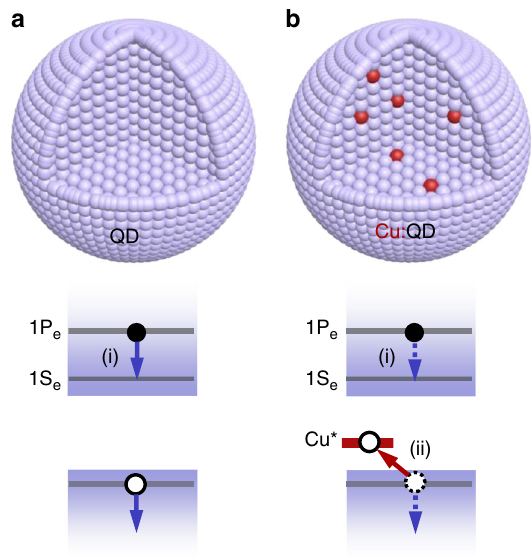
Fig. 1 Suppression of hot electron cooling in Cu-doped QDs. a In typical QDs, hot electrons relax on a sub-ps timescale through an Auger-like process whereby the electron relaxation energy is used to excite the hole in the valence band, denoted as process (i). b In Cu:QDs, ultrafast hole capturing (ii) by the intragap copper states (Cu*) decouples electrons and holes, thus suppressing Auger cooling of electrons and enabling a phonon bottleneck for hot